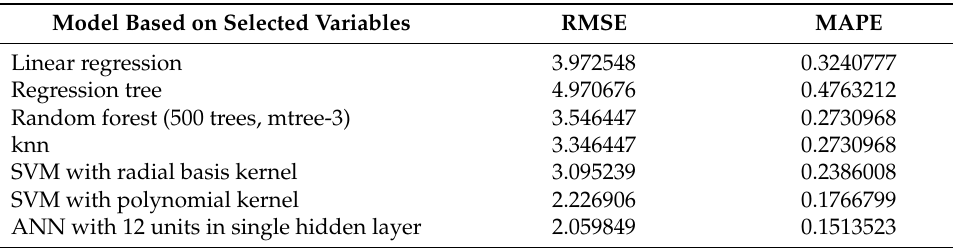
Table 3. The predictive accuracy for selected features.